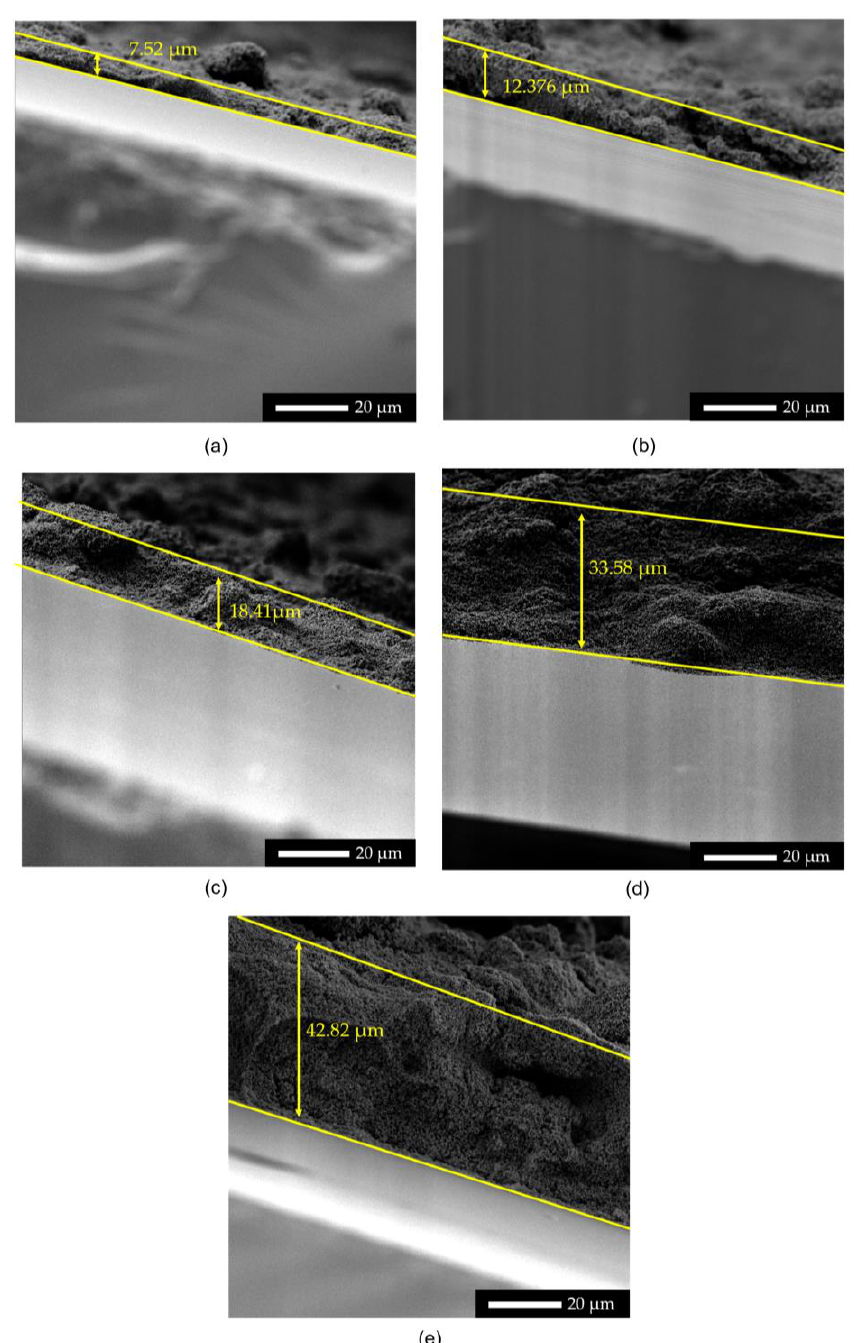
Figure 4. Cross-section of ZnO photoanodes on FTO glass: ( a ) 1 layer, ( b ) 2 layers, ( c ) 3 layers, ( d ) 4 layers, and ( e ) 5 layers.